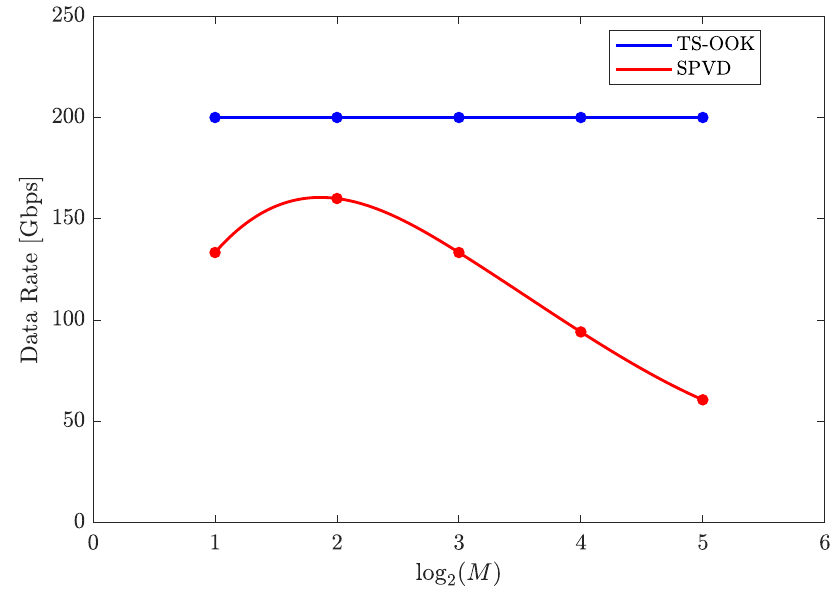
Figure 5. Transmission Data Rate.